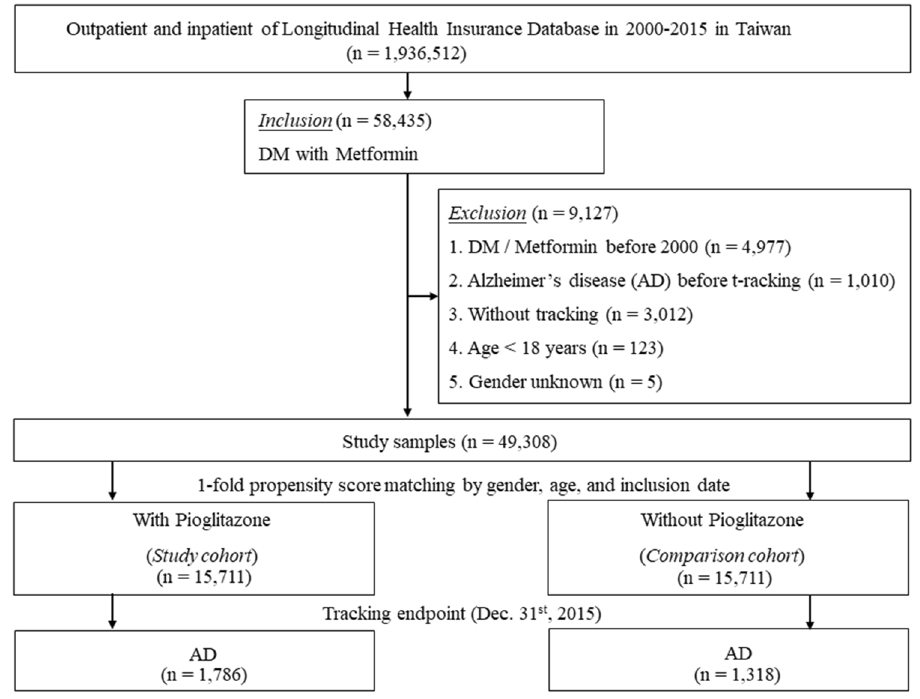
Figure 1. Flowchart for selection of study